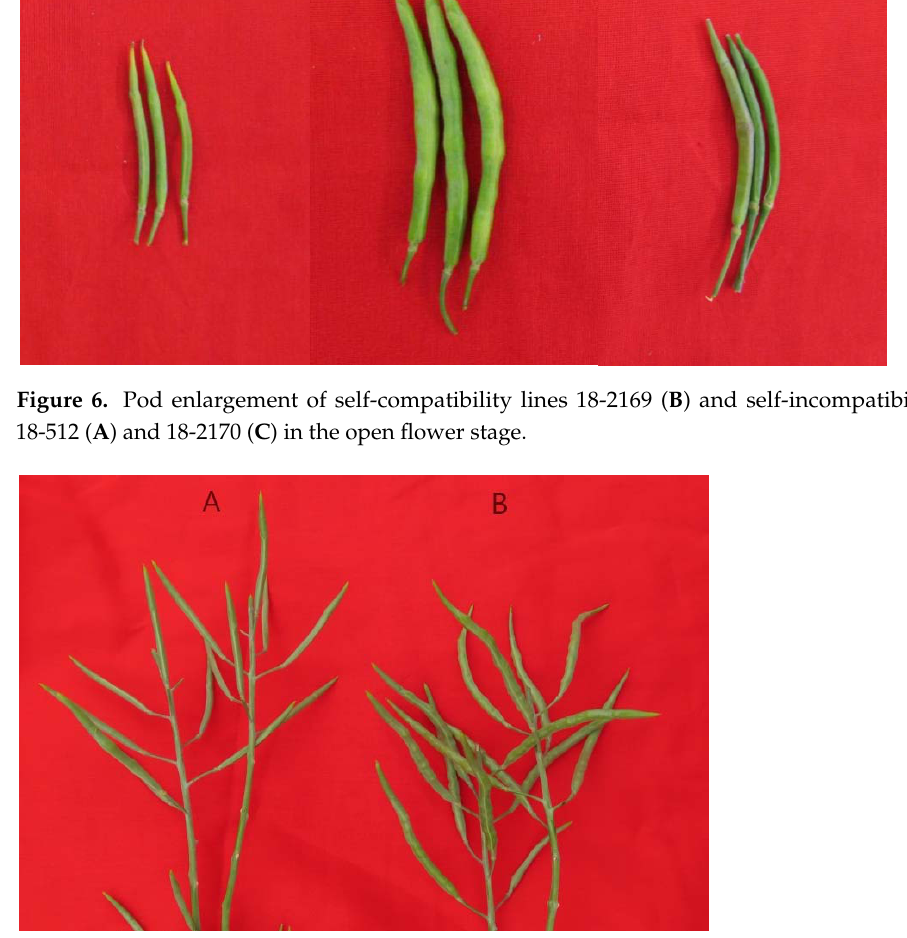
Figure 7. Pod enlargement results from hybridization of 18 ‐ 2170 and 18 ‐ 503 ( A ) and hybridization of 18 ‐ 2169 and 18 ‐ 503 ( B ) in the open flowering period.